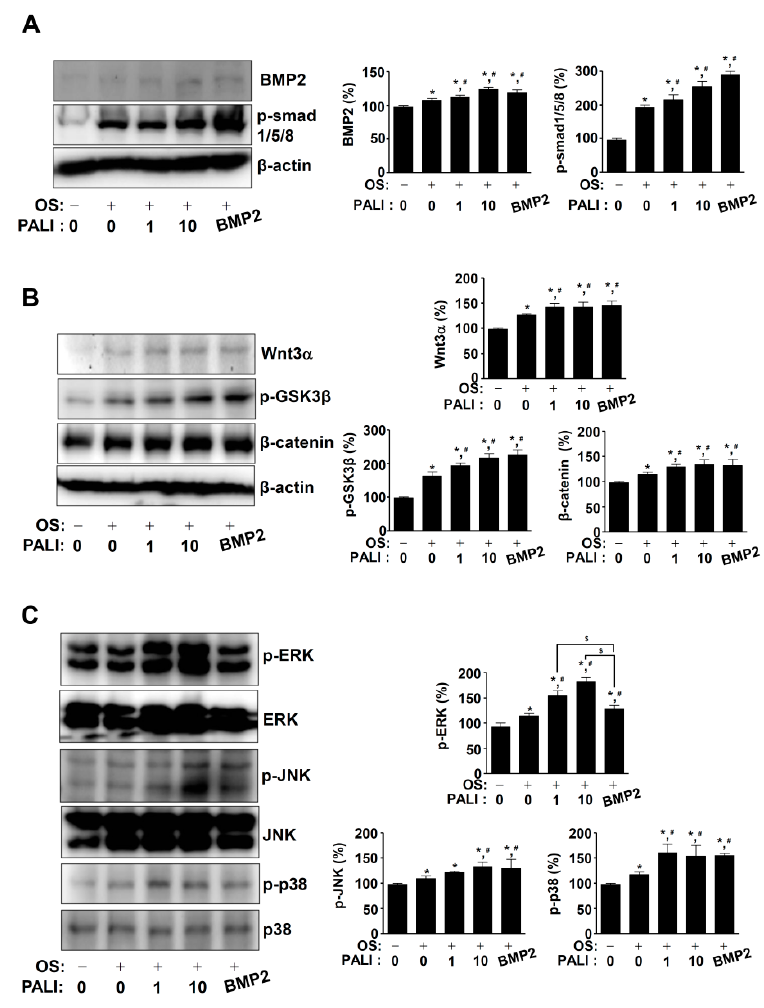
Figure 4. Effects of paeonolide (PALI) on BMP2, Wnt3, and MAPKs signaling during osteoblast differentiation. ( A – C ) After pre-osteoblasts were treated with PALI or BMP2 (100 ng/mL) during osteogenic supplement medium (OS)-induced osteoblast differentiation for 24 h, equal amounts of lysates were analyzed using Western blot analysis and detected with antibodies against BMP2, phospho-Smad1/5/8 (p-Smad1/5/8) ( A ); Wnt3a, phospho-GSK3 β (p-GSK3 β ), and β -catenin ( B ); and phospho-ERK (p-ERK), ERK, phospho-JNK (p-JNK), JNK, phospho-p38 (p-p38), and p38 ( C ). β -actin was used as a loading control. BMP2 was used as a positive control. Data are representative of the results of three independent experiments. Bar graphs are represented as relative percentages of the control. Data are representative of the results of three independent experiments and values are expressed as mean ± SEM. *, p < 0.05 indicates a statistically significant difference compared with the control; #, statistically significant difference compared with OS ( p < 0.05); $, statistically significant difference compared with the OS + PALI ( p < 0.05).